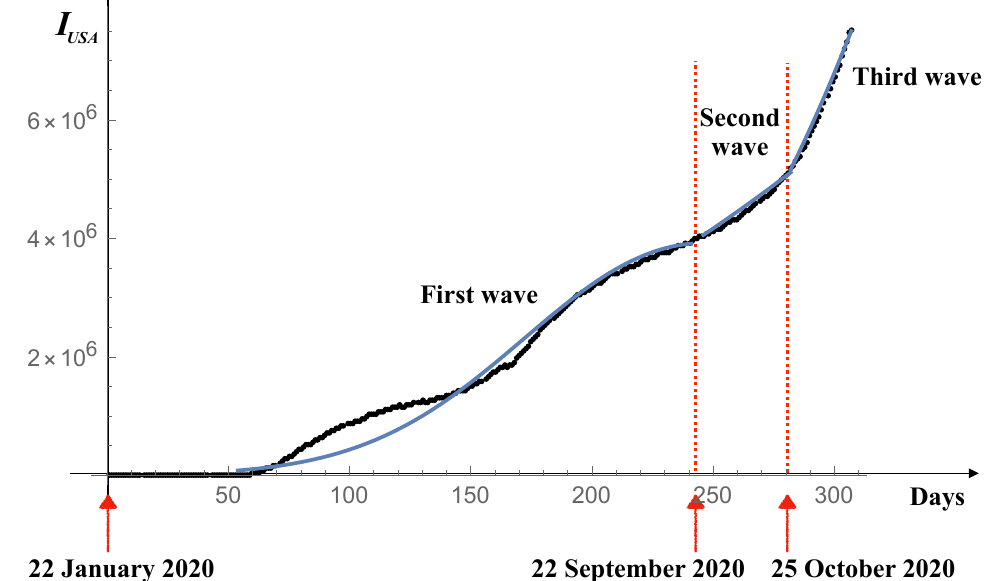
Figure 23. Comparison between theoretical predictions (blue lines) and real data (black dots) for USA by assuming that US is in the third wave of Coronavirus. The three series of values of the parameters, corresponding to the three waves, are, respectively: (˜ α = 0.043 day − 1 , β = 0.45 day − 2 ); (˜ α = 0.021 day − 1 , β = 0.008 day − 2 ), and (˜ α = 0.01 day − 1 , β = 0.02 day − 2 ). K = 25,000,000 and t L = 54